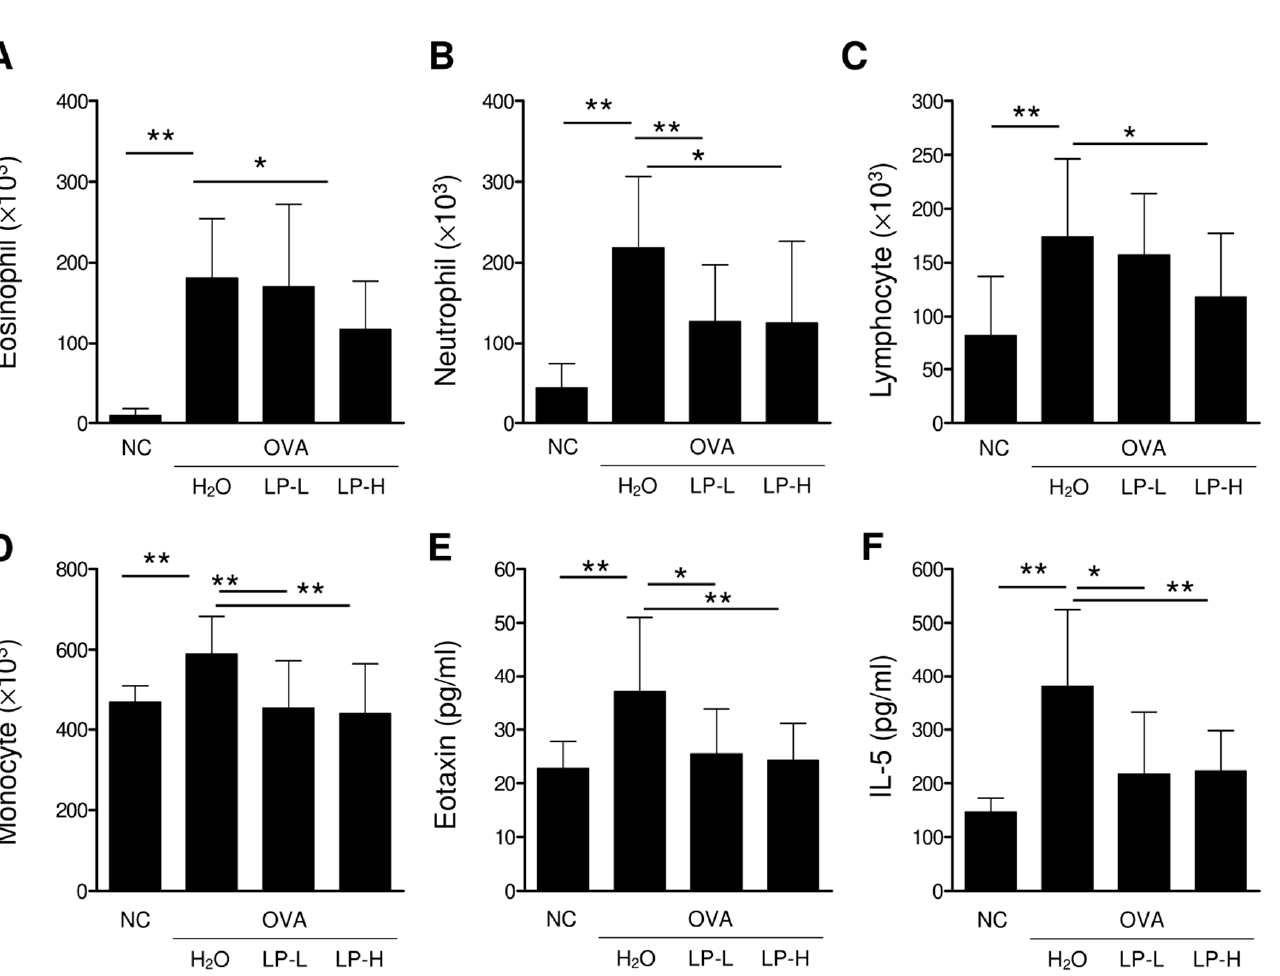
Figure 5. Effects of oral GM-080 on immune cell infiltration and eosinophilic cytokines in lungs of mice with AHR. BALF was collected 2 days after the final OVA challenge followed by centrifugation, and the cell pellet was collected. ( A – D ) Eosinophil ( A ), neutrophil ( B ), lymphocyte ( C ), and monocyte ( D ) infiltration was evaluated through microscopy after staining cells with Liu’s stain. ( E , F ) Eotaxin ( E ) or IL-5 ( F ) levels in BALF was determined using commercial ELISA kits. NC, nontreated control; H 2 O, H 2 O ga- vage; LP-L, GM-080 at 2 × 10 6 CFU/mouse/day through gavage; LP-H, GM-080 at 1 × 10 7 CFU/mouse/day through gavage. * p < 0.05, ** p < 0.01.